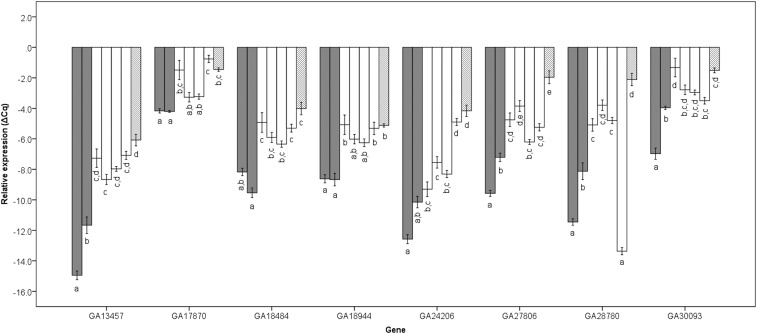
Mean relative expression and standard error of genes misregulated in X-allele introgressions. Parental species are shown in gray, IG progeny in white and sterile F1 males are hatched. For each gene, from left to right, D. p. bogotana, D. p. pseudoobscura, F8y, F8y+, F8se, F8se+. Shared letters identify non-significantly different groups (post-hoc Scheffe’s test, FDR corrected q< 0.05).